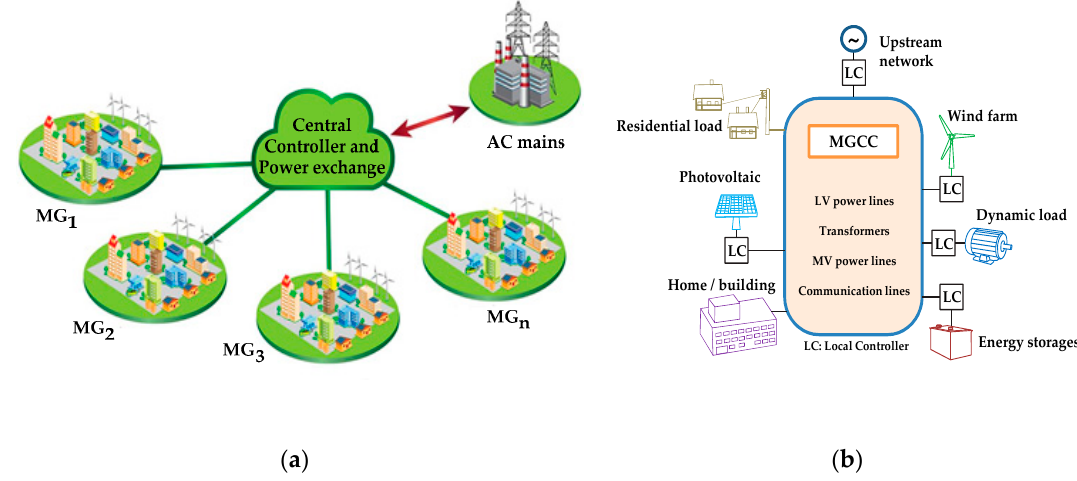
Figure 1. ( a ) Power exchange for microgrids (MGs) and the upstream network; ( b ) the equipment of a typical MG.